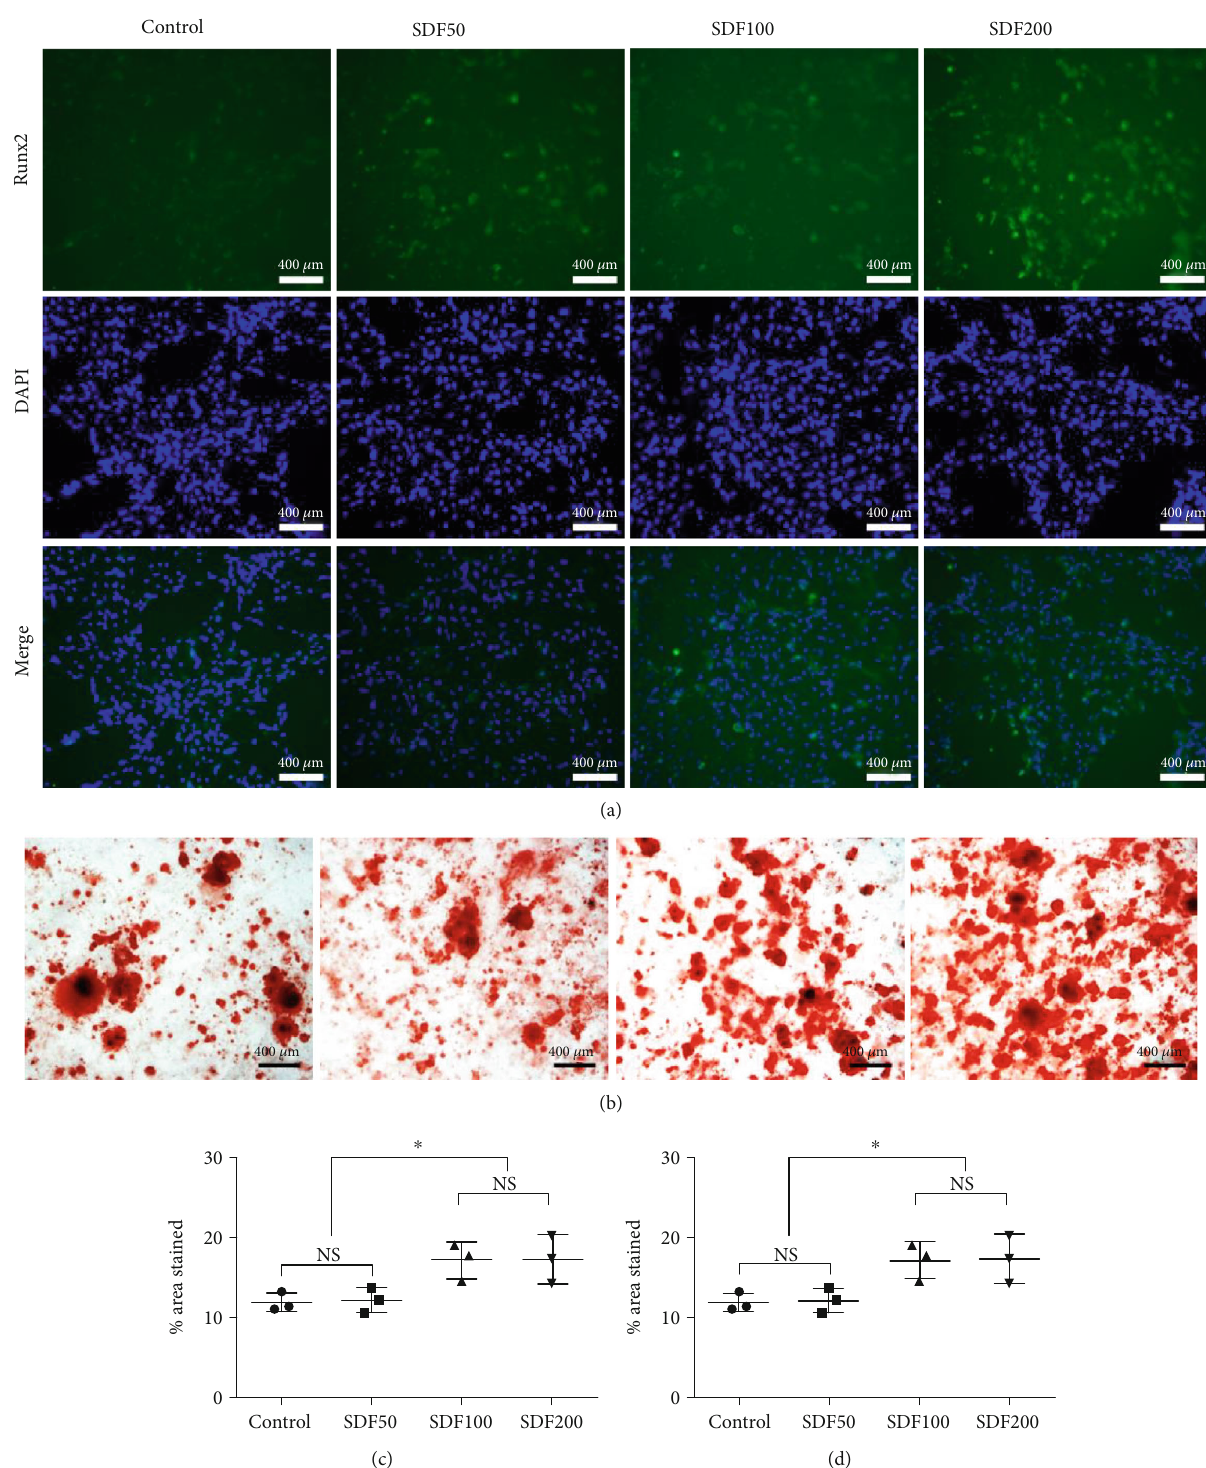
Figure 5: Osteogenic di ff erentiation assays of MSCs after 21 days of culture on the four groups of SDF-1 α /OPF/BP composites. (a) Runx2 immuno fl uorescence staining on the 21 st day of osteogenic di ff erentiation. (b) Alizarin Red S staining on the 21 st day of osteogenic di ff erentiation. (c) The percentage of Runx2-positive areas of the SDF200 and SDF100 groups was signi fi cantly higher ( ∗ p < 0 : 05 ) than that of the SDF50 and control groups. (d) The percentage of Alizarin Red S stained area of the SDF200 and SDF100 groups was signi fi cantly higher ( ∗ p < 0 : 05 ) than that of the SDF50 and control